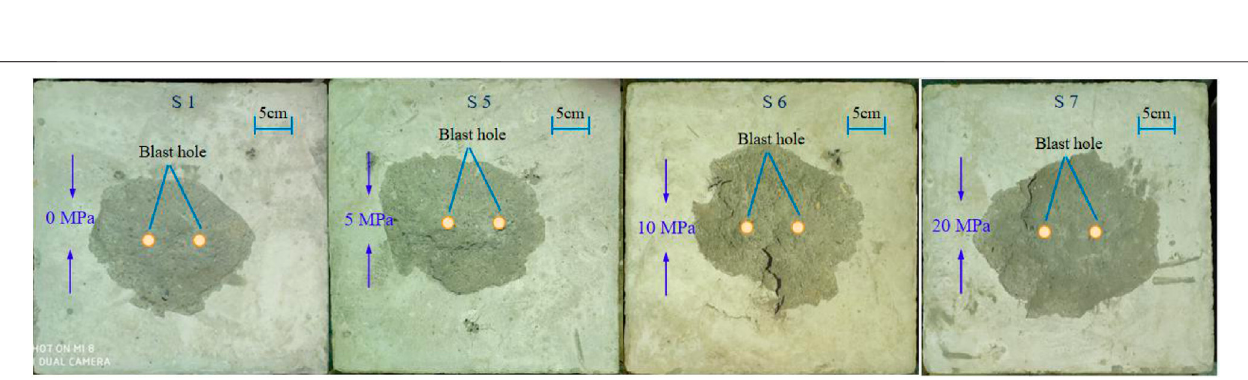
FIGURE 7 | Shape of the crater under vertical hole con fi ning